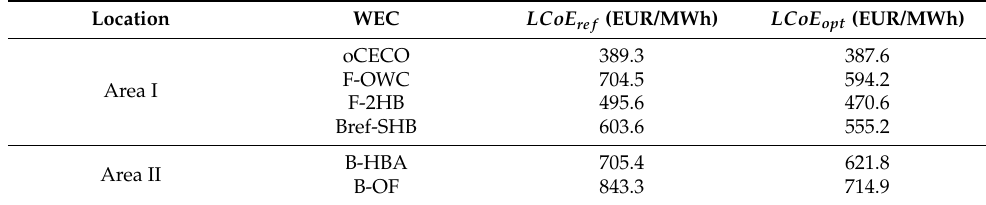
Table 5. Input parameters for the LCoE